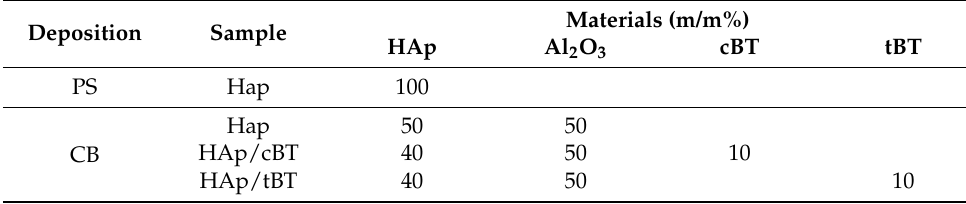
Table 2. Coating method of deposition and